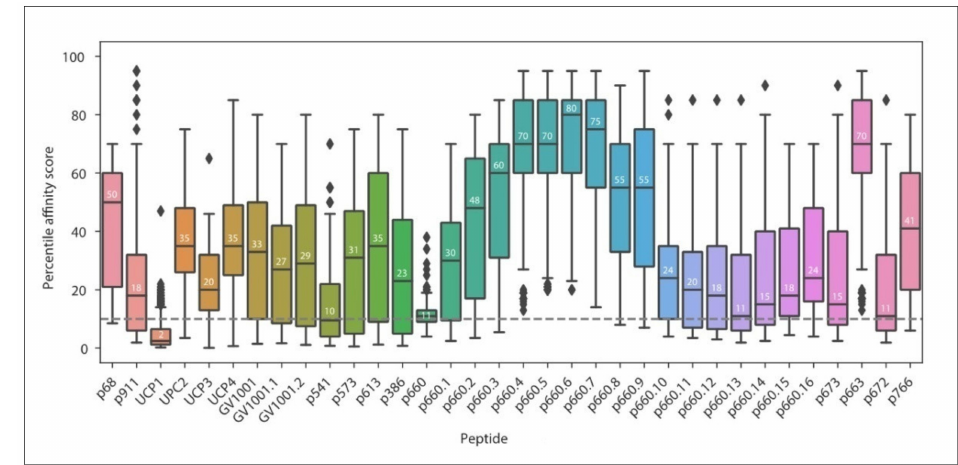
Figure 5. Overview of the promiscuous property of known TERT MHC-II-restricted peptides using NetMHCIIpan3.2. Predicted a ffi nity scores for each known TERT peptide (Table 1) across 1911 molecules containing common MHC-II alleles ( > 10% expression, see Figure 3). Peptides with an a ffi nity score < 10 are considered binders. A ffi nity for peptides longer than 15 amino acids was evaluated for each 15mer within the sequence (sub-peptides indicated with decimal points). The median percentile rank a ffi nity score is shown in each boxplot. The dotted line indicates the threshold for high a ffi nity MHC